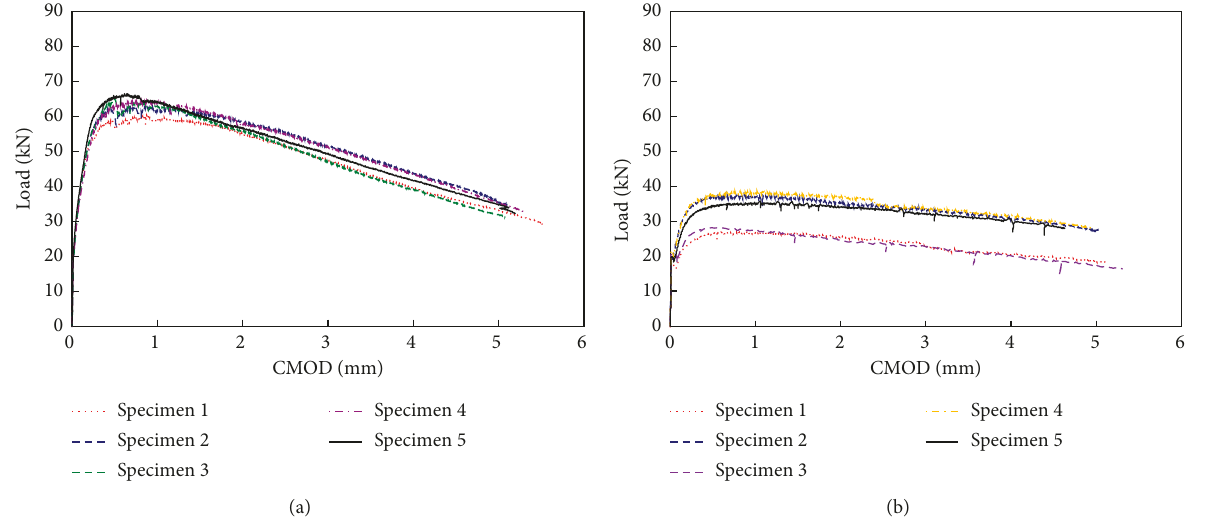
Figure 6: Comparison of the load-CMOD curves of the F15 series mixtures. (a) F10-S-L130 mixture. (b) F10-H